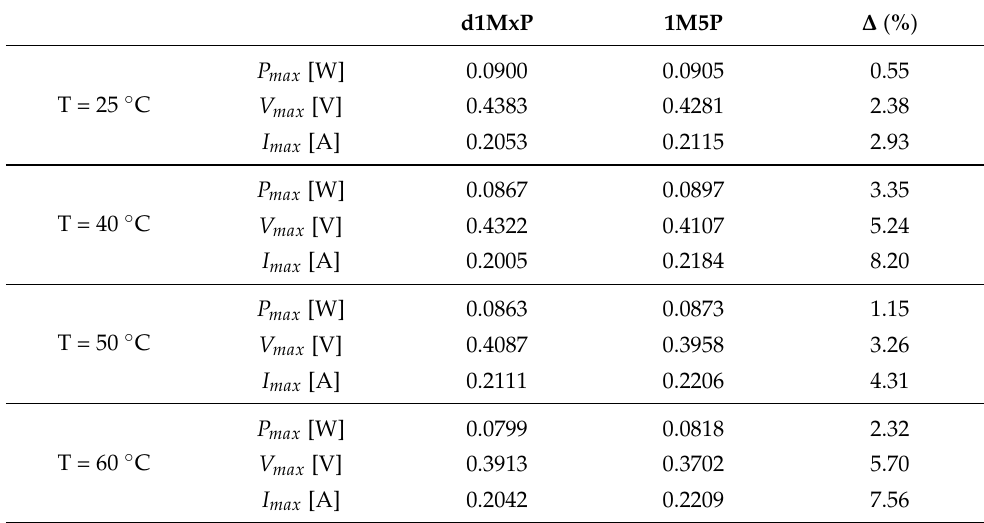
Table 5. Maximum power ( P max ), maximum voltage ( V max ) and maximum current ( I max ) values obtained with the proposed and the 1M5P models.